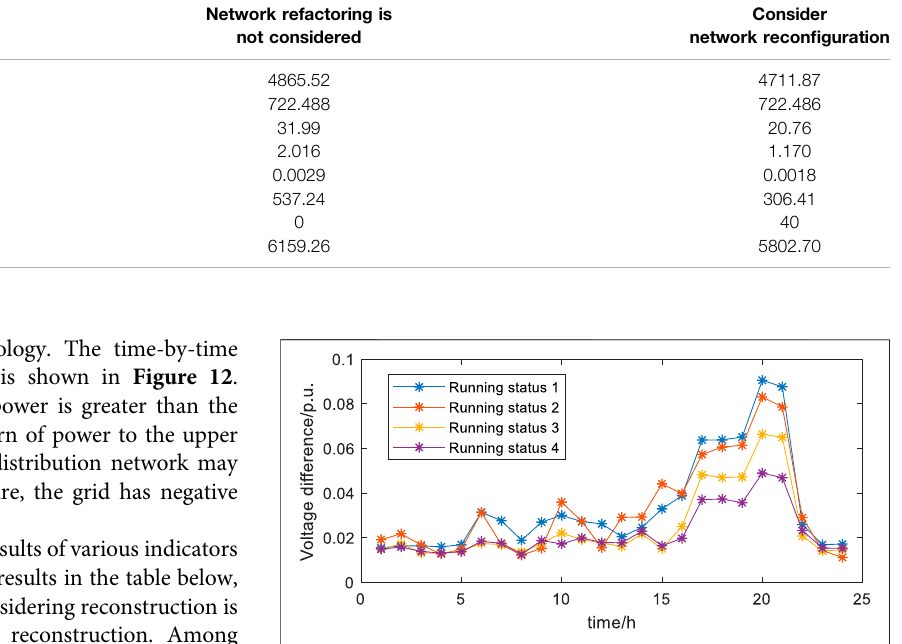
TABLE 1 | Comparison of the results of the two strategies. Optimization objectives